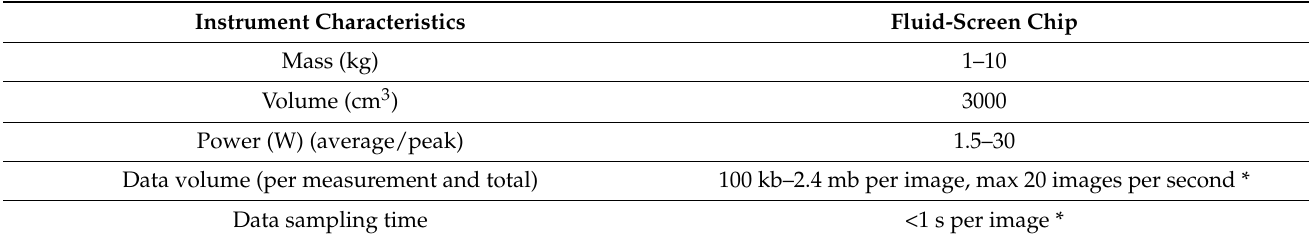
Table 2. An overview of the FS Chip configurations of Fluid-Screen with potential application to VLF